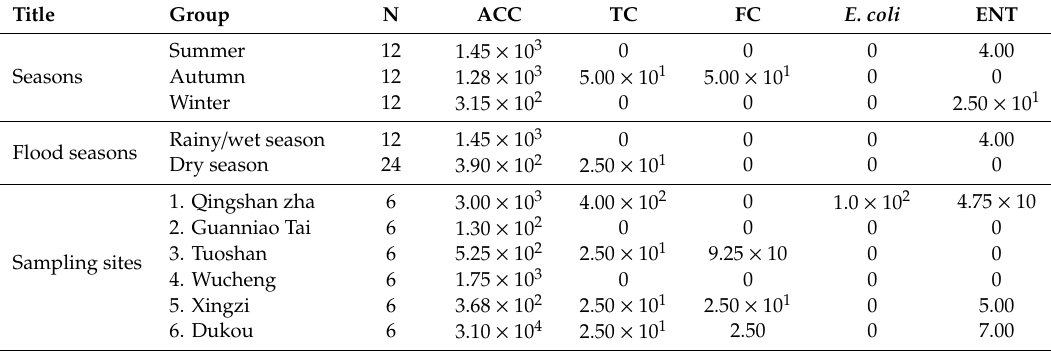
Table 5. Concentration of bacterial indicator in Poyang Lake among di ff erent seasons and sampling sites (CFU / mL).